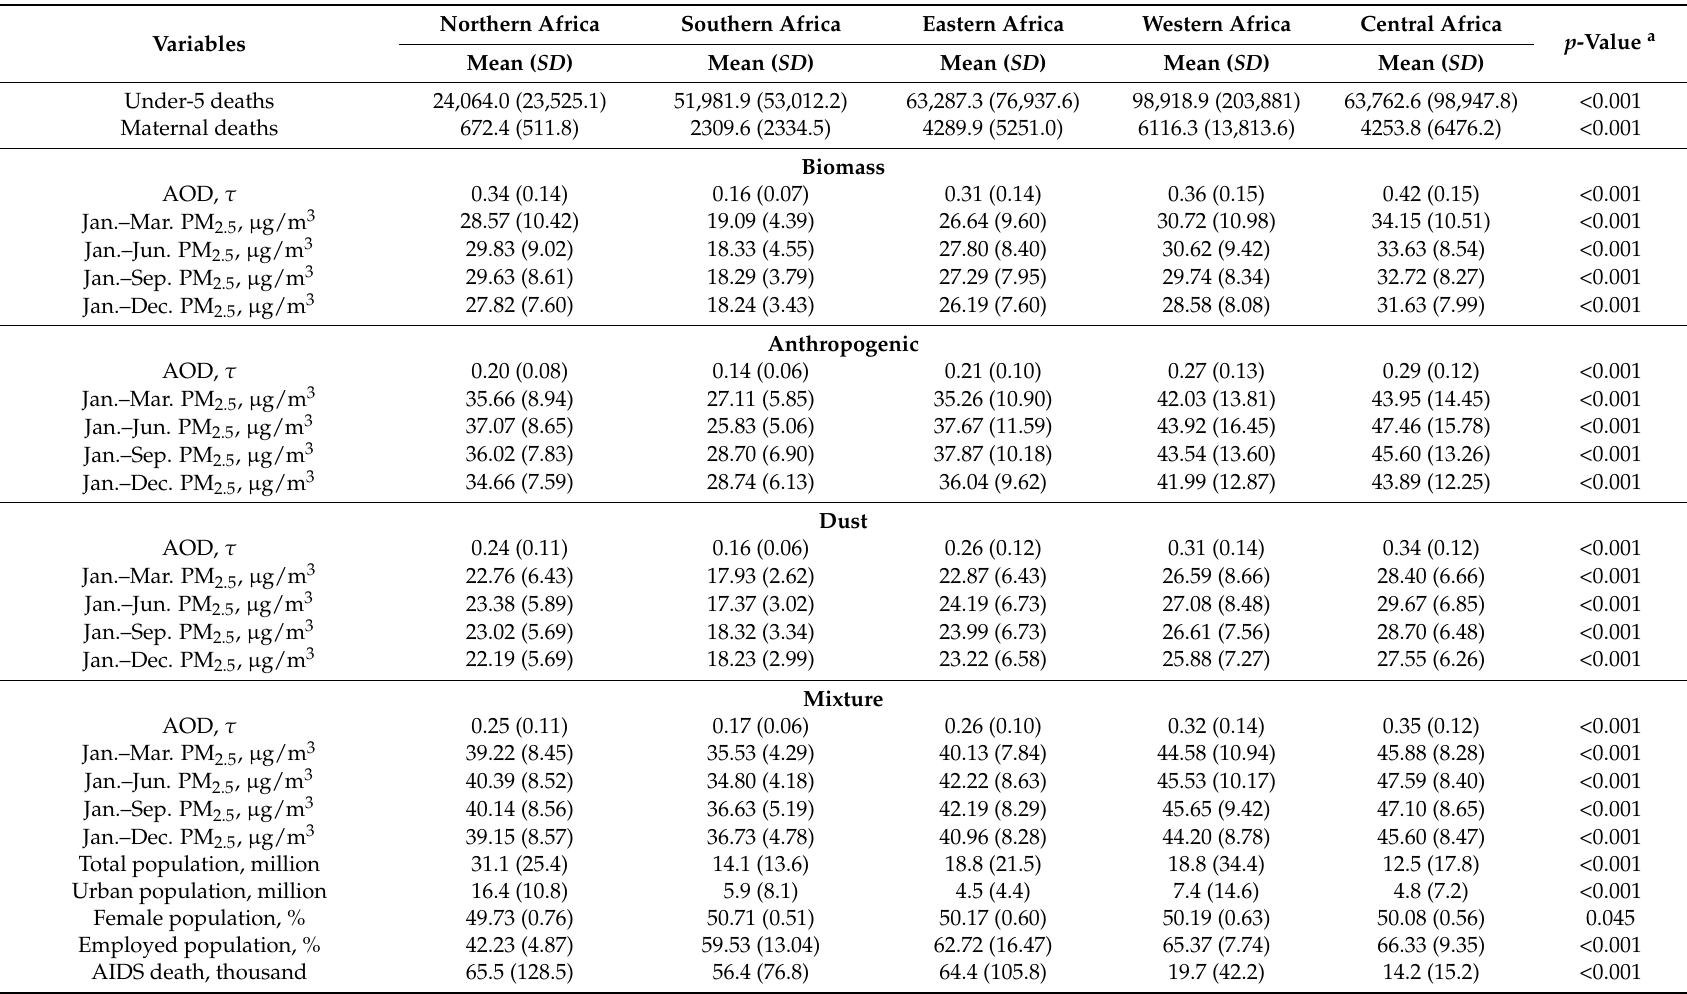
Table 1. Descriptive statistics of long-term under-five and maternal deaths, aerosol optical depth (AOD), types of PM 2.5 and population characteristics, by Africa’s sub-regions from 2000 to